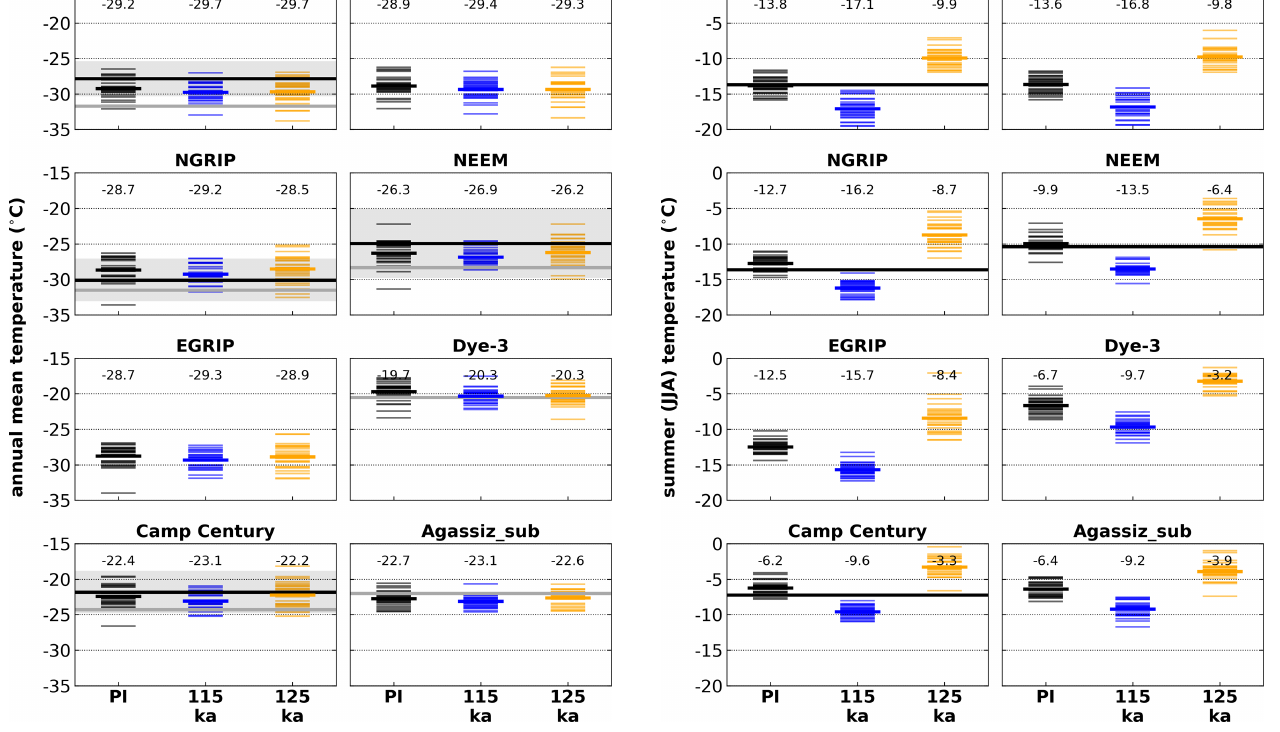
Figure 2. Annual mean (near-surface) temperature at Greenland ice core locations simulated by the MAR climate model for three time slices. Individual model years (short thin lines) and their mean (short bold lines, numerical values on top of columns) are com- pared to mean observations from weather stations (long bold lines in black), their corresponding standard deviation (gray shading), and 10m borehole temperatures (annual mean; long bold lines in gray).